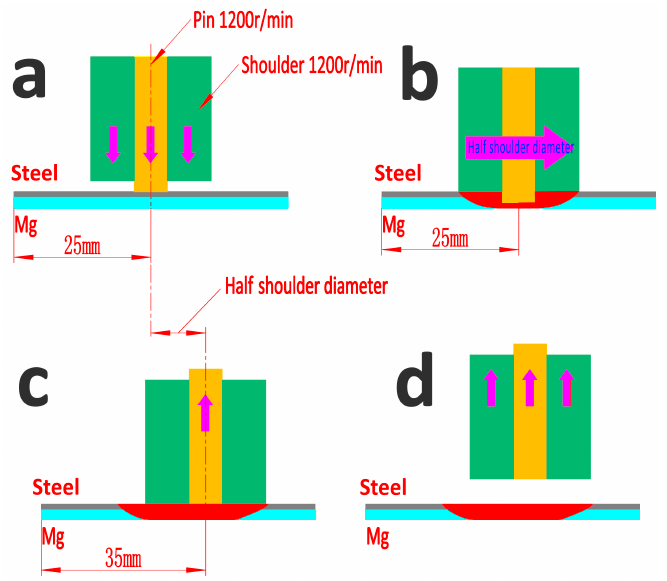
Figure 1. The diagram of new keyholeless spot welding: ( a ) The start of welding; ( b ) the welding process with the retraction of the pin; ( c ) the finished retraction; and ( d ) the end of welding.